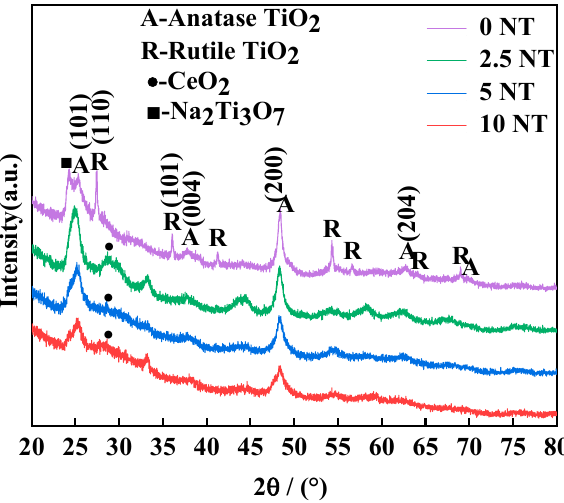
Figure 3. XRD patterns of the Ce-doped TNTs.